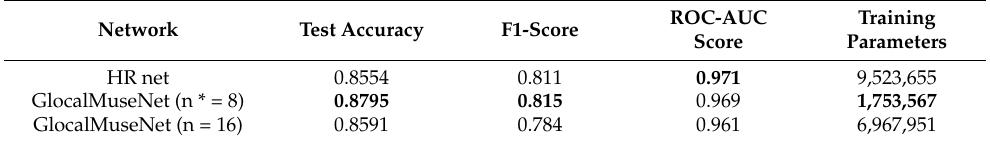
Table 3. Classification score of rhythm